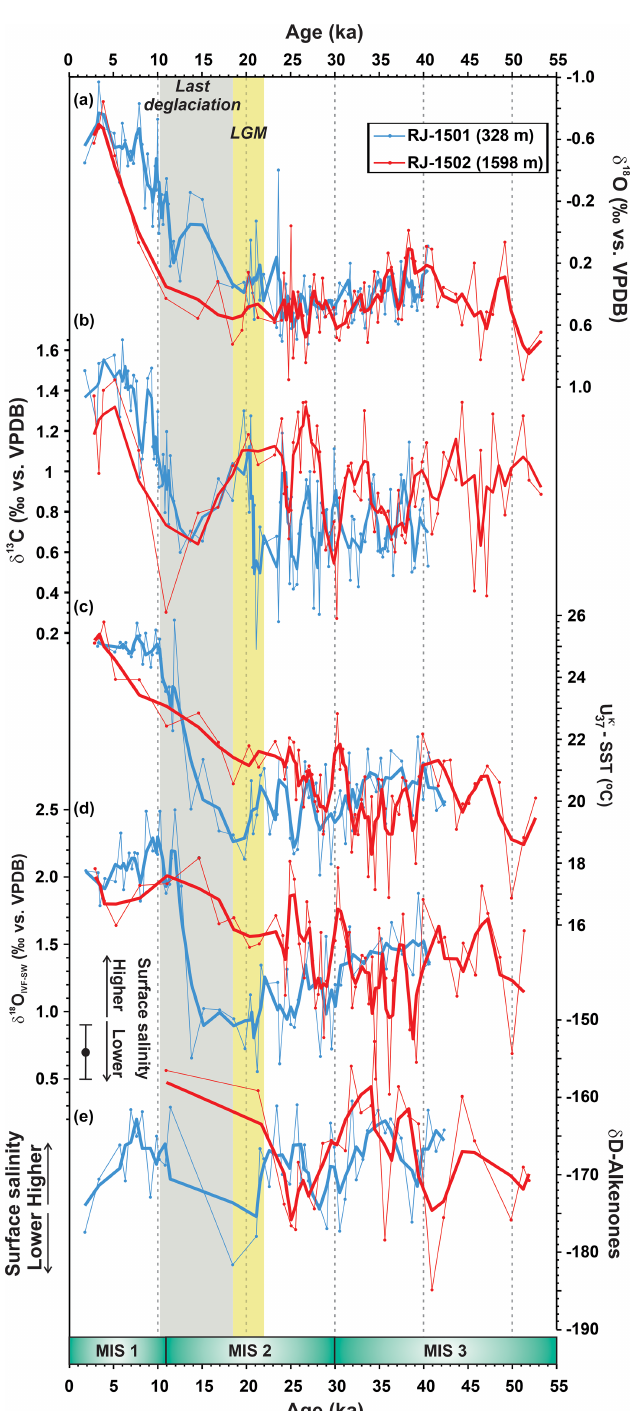
Figure 3. Organic and inorganic proxies developed from marine sediment cores RJ-1501 (blue) and RJ-1502 (red). (a) Oxygen isotope ( δ 18 O) of the planktic foraminifera G. ruber . (b) Carbon isotope ( δ 13 C) of planktic foraminifera G. ruber . (c) Alkenone (U K surface temperature (SST). (d) Ice-volume free seawater oxygen isotope ( δ 18 O IVF − SW ) derived from the δ 18 O composition of G. ruber and (cid:48) U K -derived SST. (e) δ D-Alkenones. Records are depicted by the original data (dots and thin line) and the respective three-point running 37 average (thick line). Yellow and grey bars denote the Last Glacial Maximum (LGM) and last deglaciation, respectively. The vertical bar at the left of panel (d) indicates the total uncertainty associated with the δ 18 O IVF − SW . Marine isotope stages (MIS) are indicated at the bottom of the